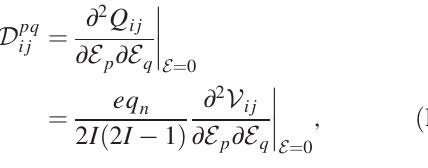
for (a) zinc-blende GaAs and (b) Sb defect in x